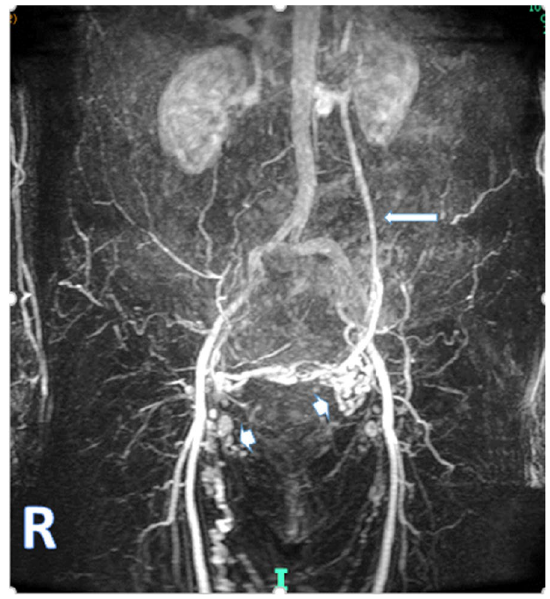
Fig. 4 MRI/MRv The left ovarian vein (long arrow) is clearly identified filling early and extends down into the pelvis where small varices (arrow head) are filled on the left side with a crossover of venous flow to the right side and subsequent multiple varicosities are identified in the right upper thigh on this TR IC K S